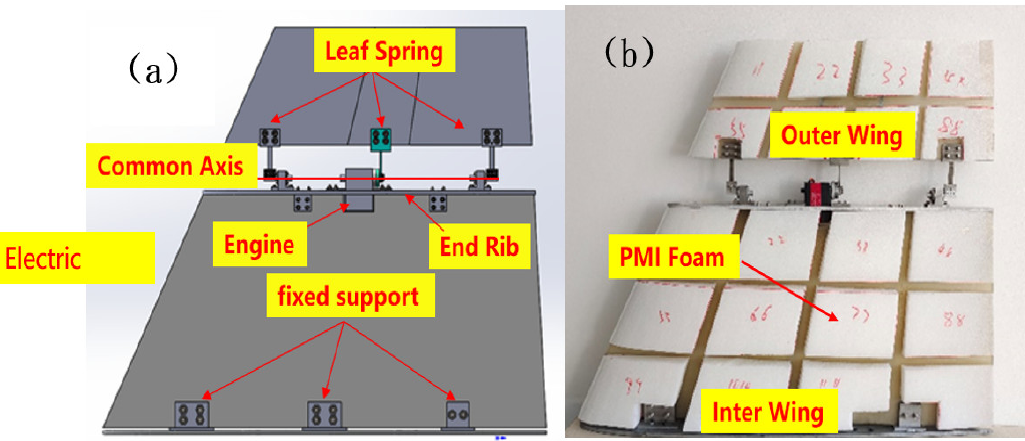
Figure 1. Folded wing similar model: ( a ) SolidWorks designed model; ( b ) Experimental model.